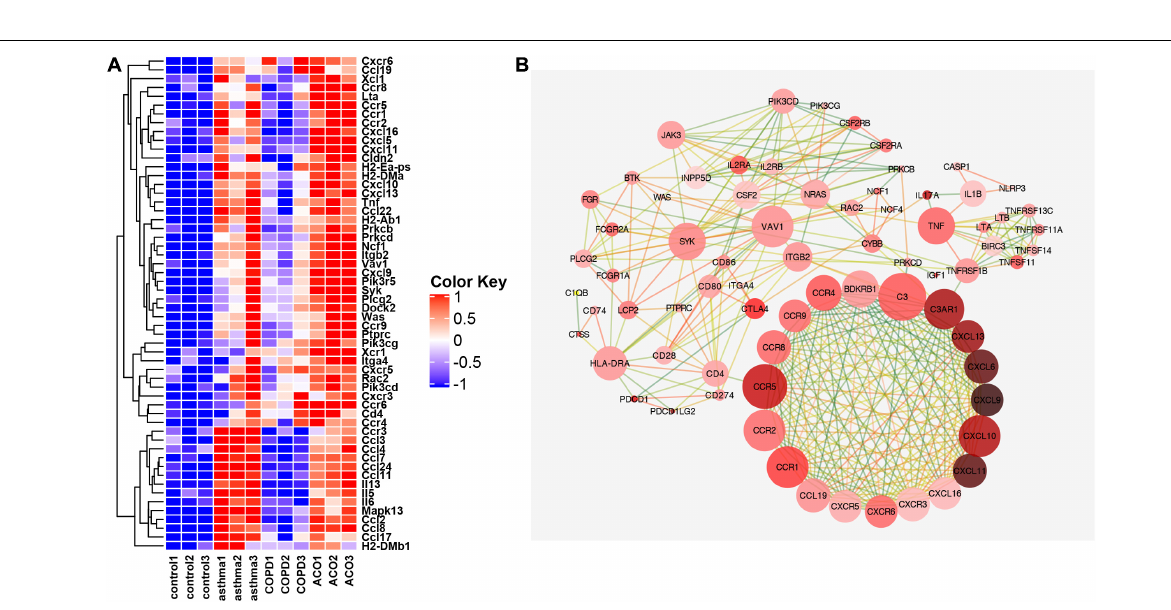
Frontiers in Cell and Developmental Biology |